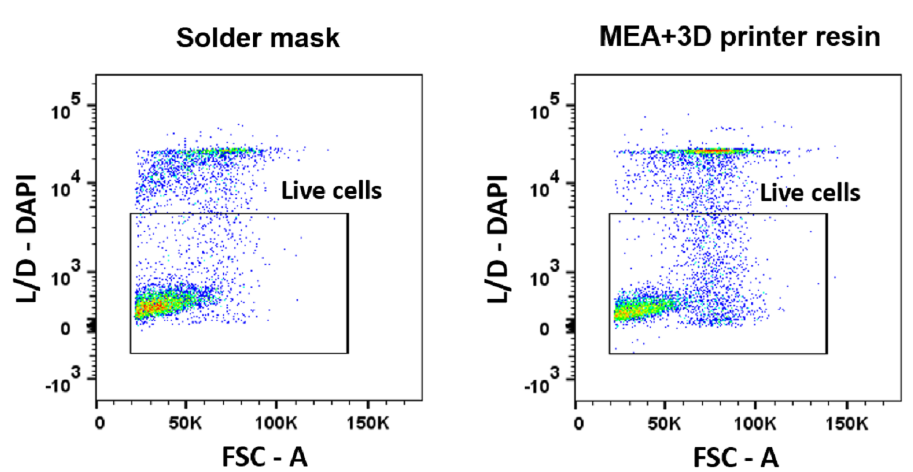
Figure 6. Biocompatibility measured in closed culture systems. Representative dot plots of cytometer acquisition data of cells cultured in PCB in a closed system and resin-based LoC system. Dead cells are positively stained for DAPI, which is displayed in the Y-axis.